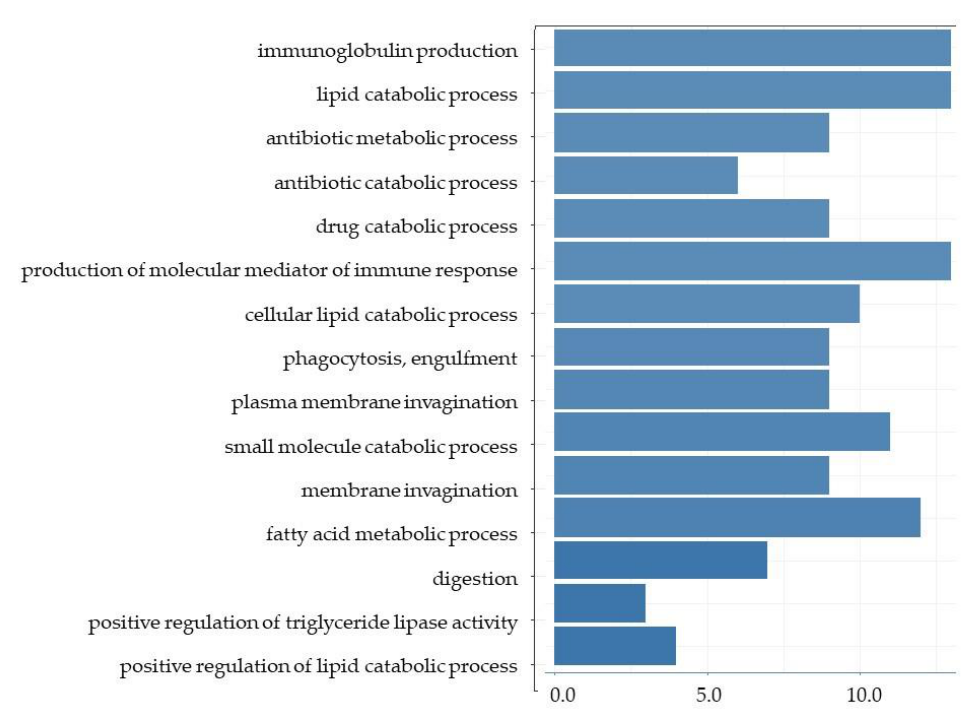
Figure 5. The top 15 GO terms from the DGAs for downregulated genes in the ileum.